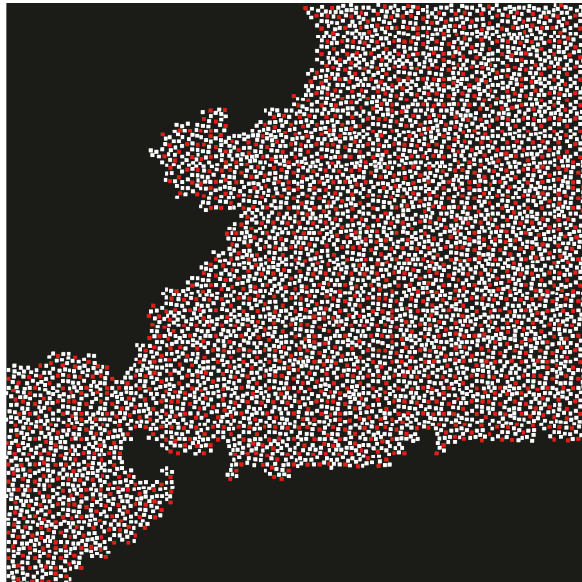
Figure 11: PDD distribution with multiple plant levels. The red points are plants with a larger plant spacing; the white points are plants with a smaller plant spacing.